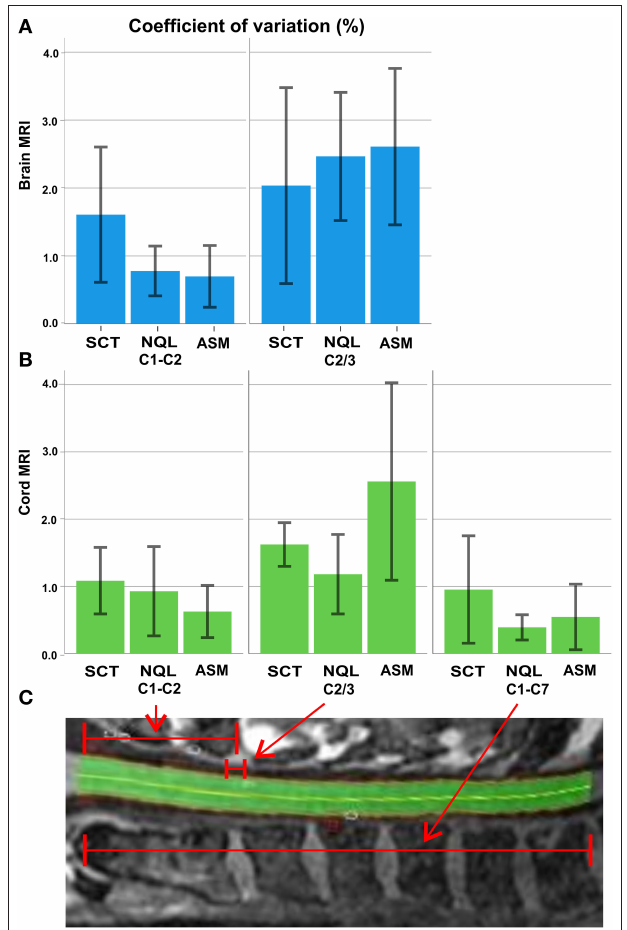
FIGURE 4 | Overview of the agreement between the evaluation methods averaged across all sites: (A) coefficient of variation (%; error bars: standard deviation) of the three software methods for brain MRI at the C1–C2 level and C2/3 level; (B) coefficient of variation (%) of the three software methods for cord MRI at the C1–C2, C2/3, and C1–C7 level; (C) illustration of the C1–C2, C2/3, and C1–C7 sections of the cervical cord (example: an NQL